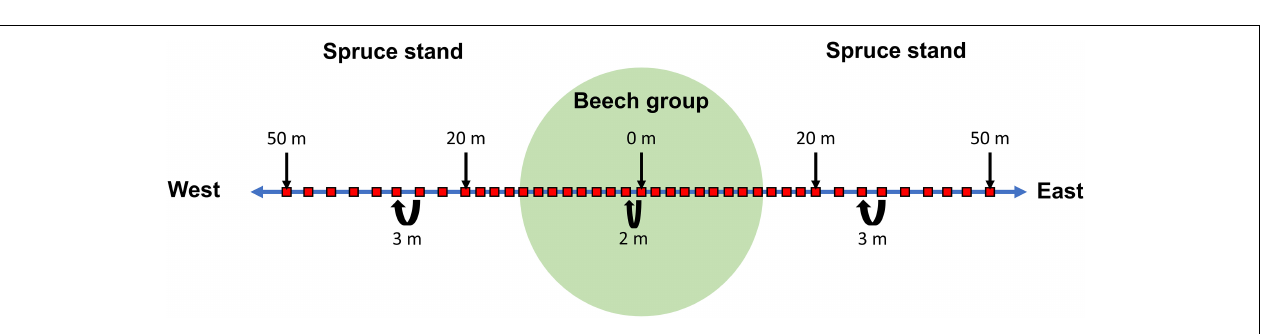
FIGURE 1 | Experimental design for the recording of the position of beech seed trees and beech natural regeneration. The position of the radiation measurements and beech seed trees is illustrated.